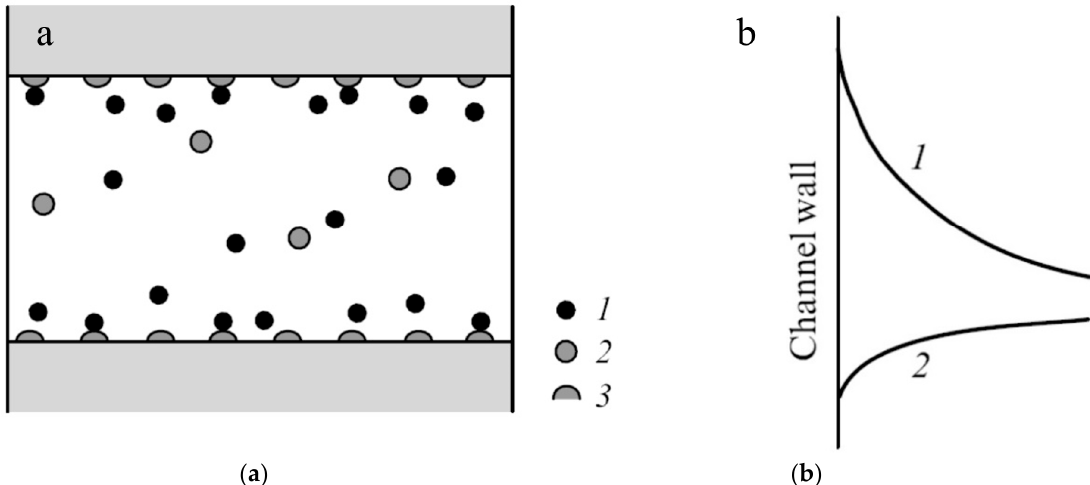
Figure 2. Distribution of counterion (1) and co-ion (2) within a pore near a charged wall with fixed functional groups (3) shown as distribution of points ( a ) or with concentration profiles ( b ). Reproduced with permission from [4], Wiley, 2012.